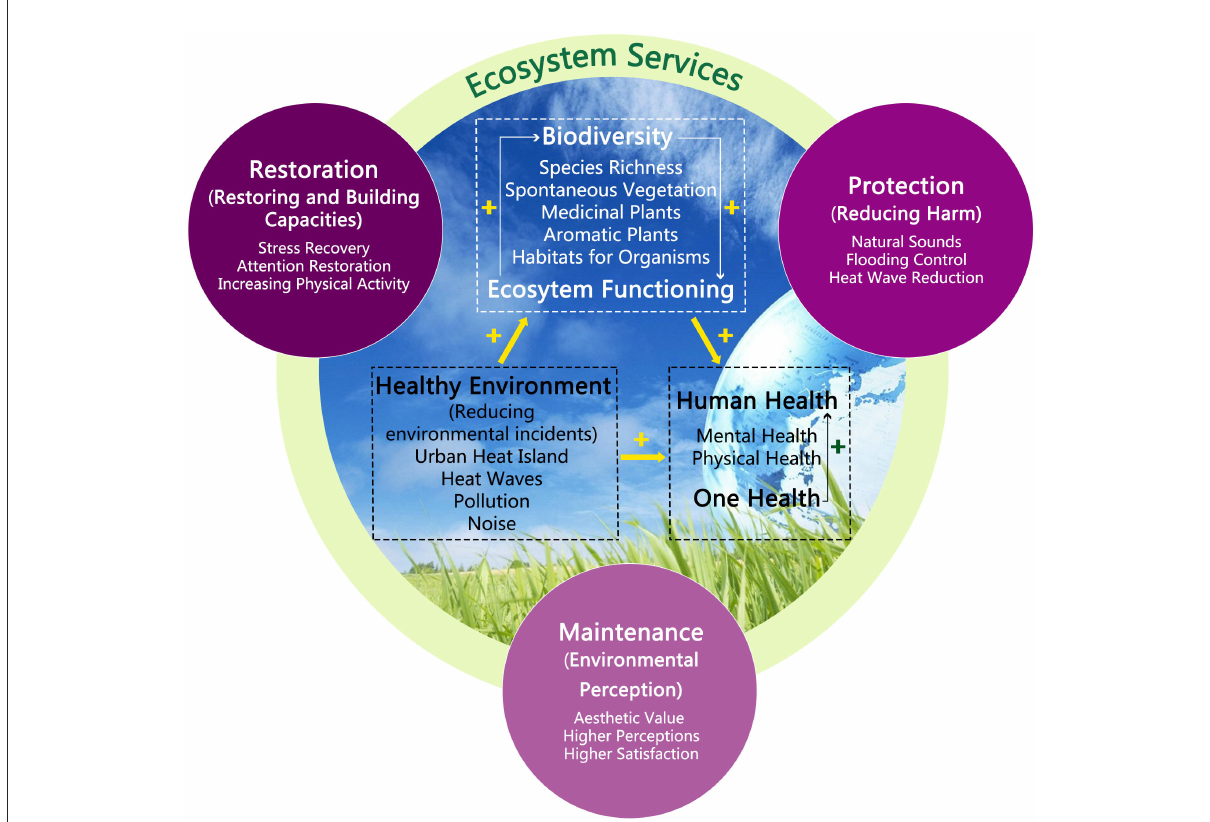
FIGURE1 A conceptual framework for the interrelationship of biodiversity, ecosystem functioning, and ecosystem services with effects on human mental and physical health. The theoretical framework involves three processes: Protection, restoration, and maintenance. Arrows indicate directions of interactions and the plus sign ( + ) represents a positive